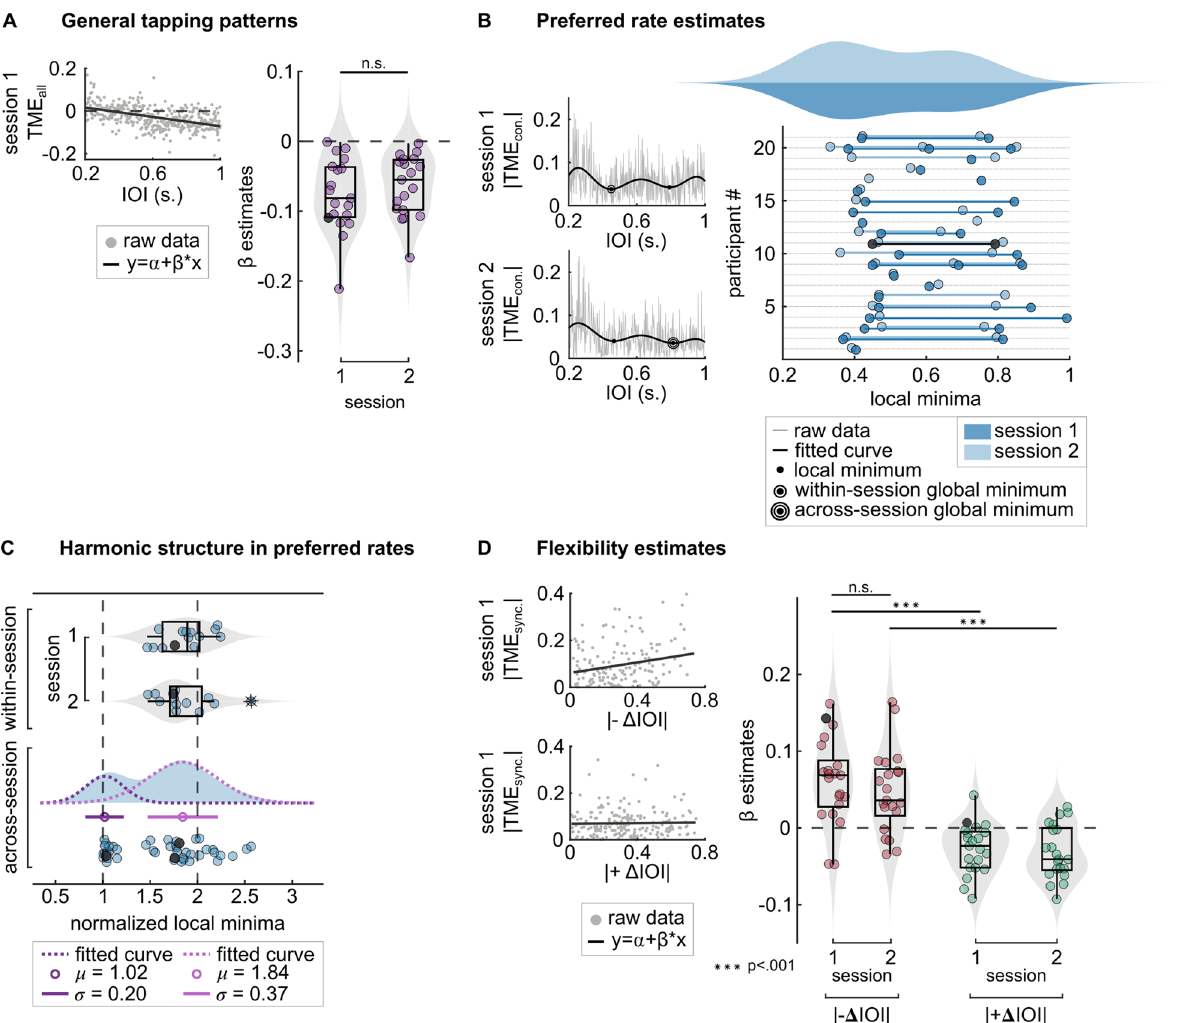
Figure 2. Main findings. ( A ) General tapping patterns across the range of stimulus IOIs. Left: an example participant’s session 1 raw data and the fitted least-squares line. Right: β estimates (slopes) obtained from the linear models (TME all = α + β × IOI), in individual sessions. Box plots show median (black horizontal line), 25th and 75th percentiles (box edges) and extreme datapoints (whiskers). Each circle represents a single participant. Black circle represents β of the line in the example fit on the left. ( B ) Preferred rate estimates. Left: an example participant’s raw data and the fitted curves in session 1 (top) and session 2 (bottom). Individuals’ preferred rates were the stimulus IOI at the local minima of the fitted curves, where the predicted |TME continuation | was minimum. Among the local minima, the ones with less predicted TME were the global minimum, obtained within and across sessions. Right: 21 participants’ local minimum estimates and the resulting distributions in session 1 (dark) and session 2 (light). Each circle represents a local minimum and the black circles represent the example participant’s estimates. ( C ) Harmonic structure in preferred rates. The plot shows normalized local minima, where each individual’s estimate was divided by the smallest value obtained within session 1 and 2 (top and middle, respectively) and across sessions (bottom). Dotted curves represent the gaussian curves, fitted to the kernel density of the bimodally distributed data. Single circles and the same-color whiskers represent mean and standard deviation of the fitted theoretical distributions. Each circle represents a normalized local minimum and the black circles represent the example participant’s estimates. Box plots show median (black vertical line), 25th and 75th percentiles (box edges) and extreme datapoints (whiskers). ( D ) Flexibility estimates. Left: an example participant’s session 1 data and the linear fits where |TME synchronization | was predicted by absolute negative ΔIOI (top) and by positive ΔIOI (bottom). Right: β estimates (slopes) obtained from the linear models where |TME synchronization | was predicted by absolute negative ΔIOI (red) and by positive ΔIOI (green), in individual sessions. Each circle represents a single participant. Black circles represent β of the lines in the example fit on the